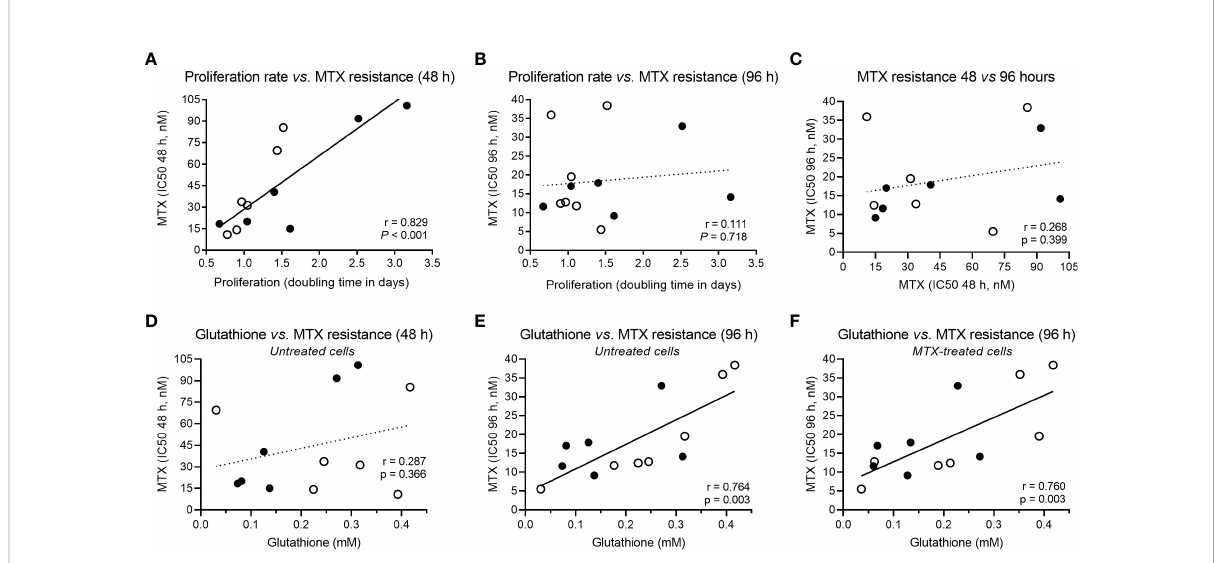
FIGURE 2 Correlation between cellular proliferation, MTX resistance and GSH levels. (A) Correlation between proliferation rate (cell doubling time) and MTX resistance (IC50) at 48 hours or (B) 96 hours, and (C) across MTX resistance over time (48 × 96 hours). (D) Correlation between constitutive GSH and MTX resistance at 48 hours or (E) 96 hours, and (F) between GSH levels in MTX-treated cells and MTX IC50 at 96 hours. Black and white beads represent BCP-ALL and T-ALL cell lines, respectively. P -values and r are from Pearson